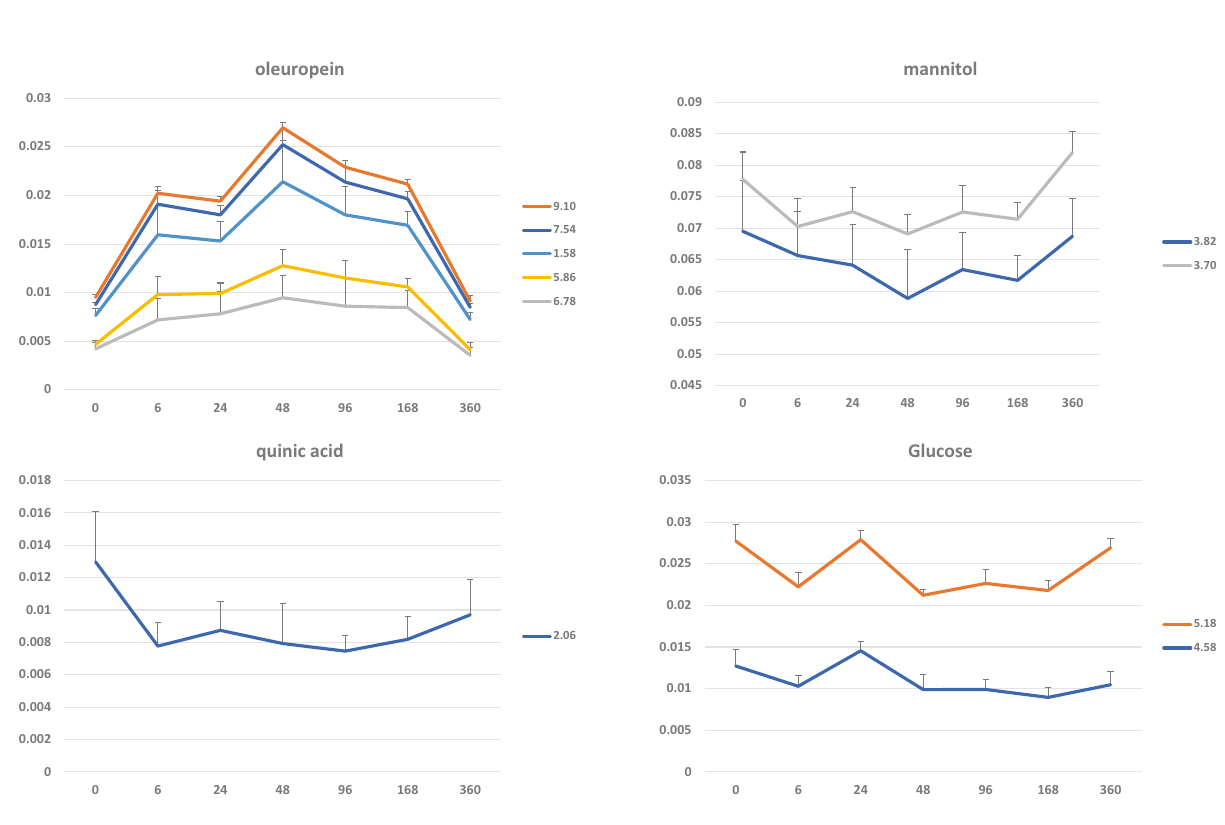
Figure 4. Time course of discriminating metabolites related bucket at different intervals of 0, 0.25, 1, 2, 4, 7, and 15 days after DENTAMET injection. Mean and relative standard error refer to the average bucket intensities for each of the discriminating